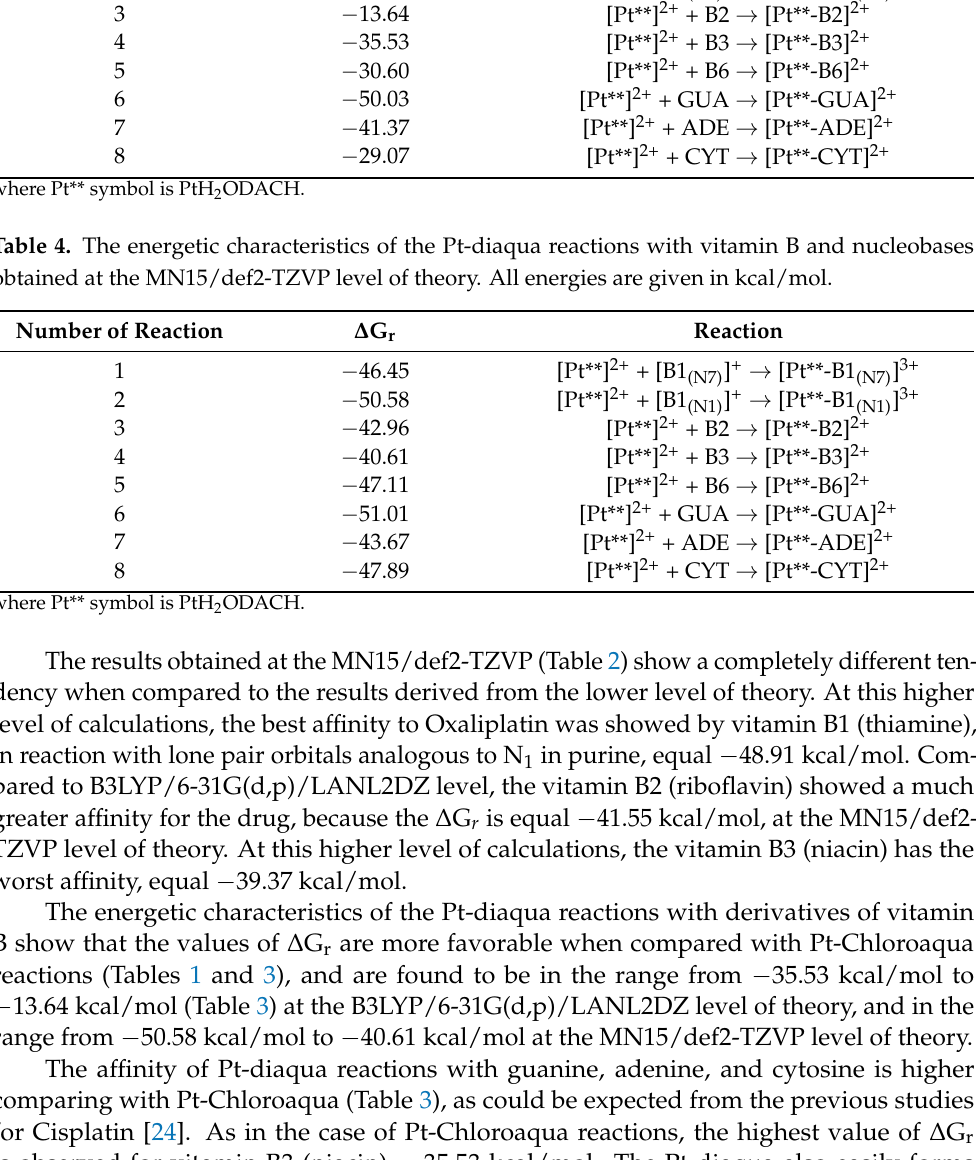
Table 3. The energetic characteristics of the Pt-diaqua reactions with vitamin B and nucleobases obtained at the B3LYP/6-31G(d,p)/LANL2DZ level of theory. All energies are given in kcal/mol. Number of Reaction ∆ G r Reaction 1 − 25.10